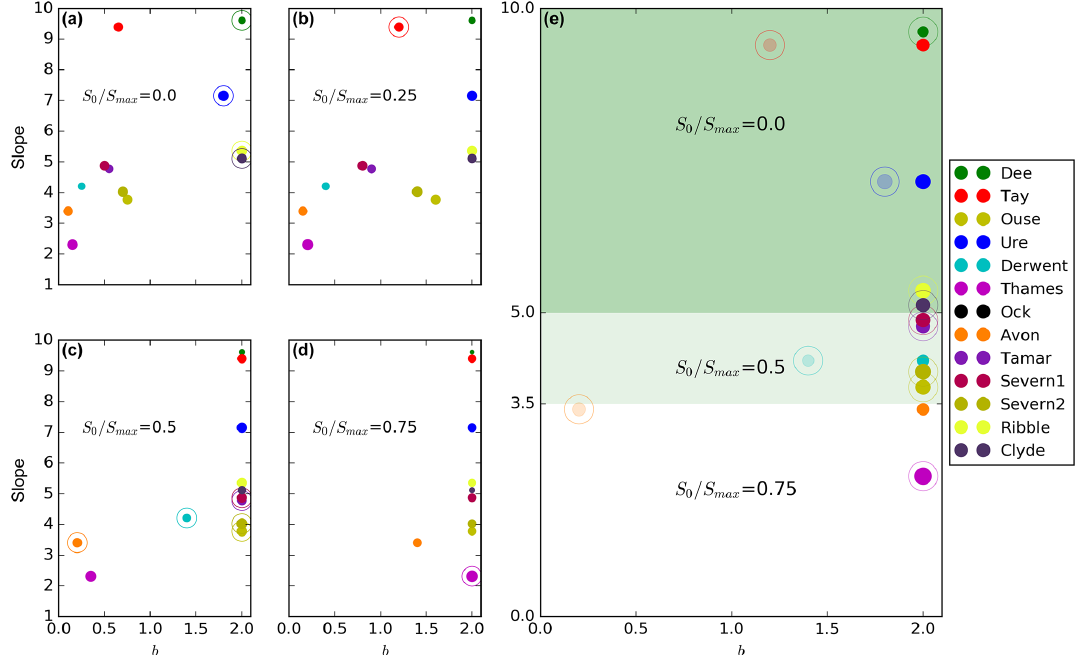
Figure 6. (a–d) Representation of the b parameter value ( x axis) of catchment tests that obtained a better NS metric for a given value of S 0 /S max (stated inside each plot) against the mean catchment slope on the y axis. The marker size represents the NS values (larger circles for higher NS values). Tests highlighted with an outer circle indicate the best performance of all tests for a given catchment (so the panel where they are indicates S 0 /S max and the x value indicates b ). Tests where the mean bias is higher than 30% are not considered due to a poor performance. (e) Best PDM-parameter tests selected for each catchment following the criterion mcs of fixed b = 2 and slope-dependent value of S 0 /S max are as follows: 0.0 for mean catchment slopes higher than 5.0 ◦ (green background), 0.5 for mean catchment slopes between 3.5 and 5.0 ◦ (light green background), and 0.75 for mean catchment slopes lower than 3.5 ◦ (white background). For those catchment in which mcs does not select the test of the best NS metric (Tay, Ure, Derwent, Avon), the best-performing tests are also represented with a degree of